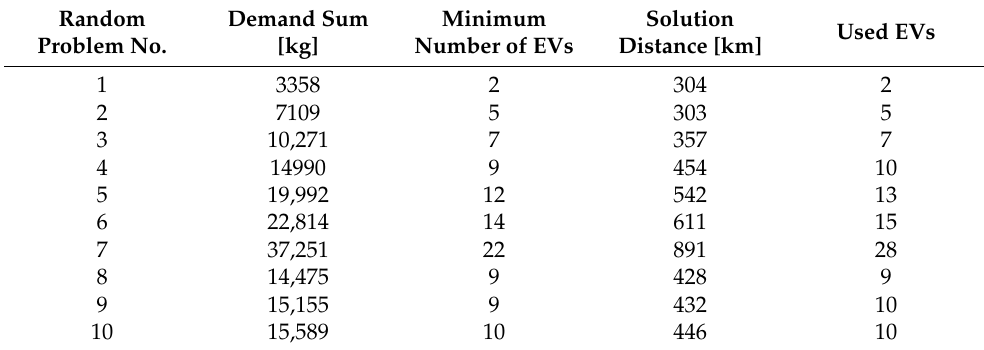
Table 2. The results obtained for scenario